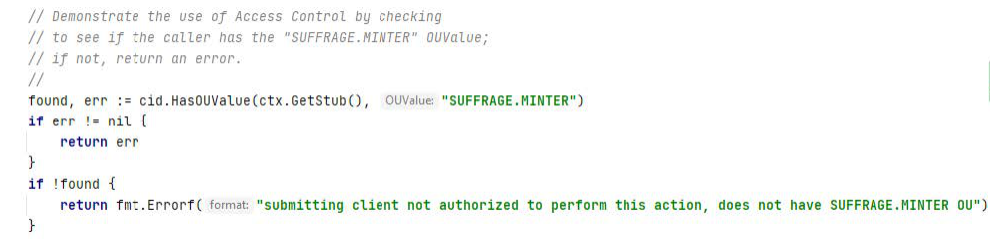
Figure 7. Access control in MINTER affiliation.